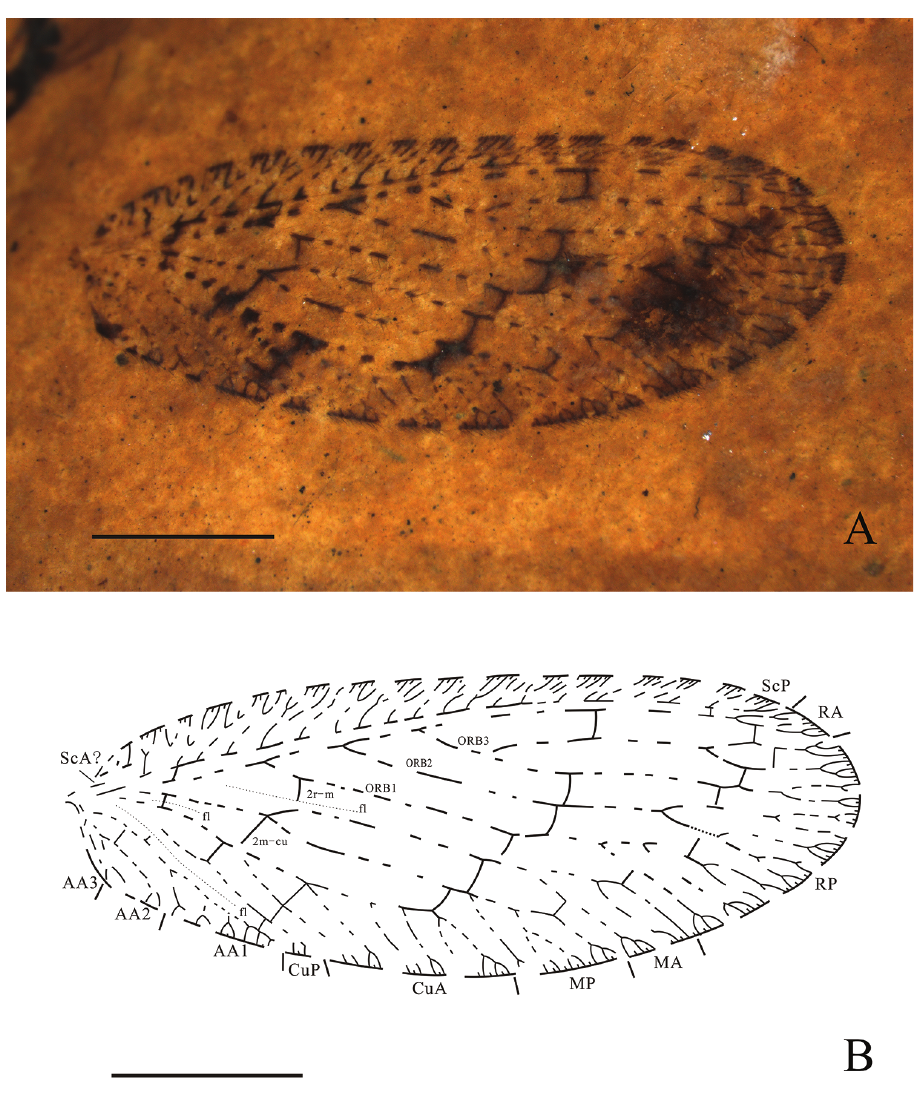
Figure 1. Wesmaelius makarkini sp. n., holotype CNU-NEU-QZ2017001. A photograph of forewing under alcohol B Line drawing of forewing. Scale bars: 2